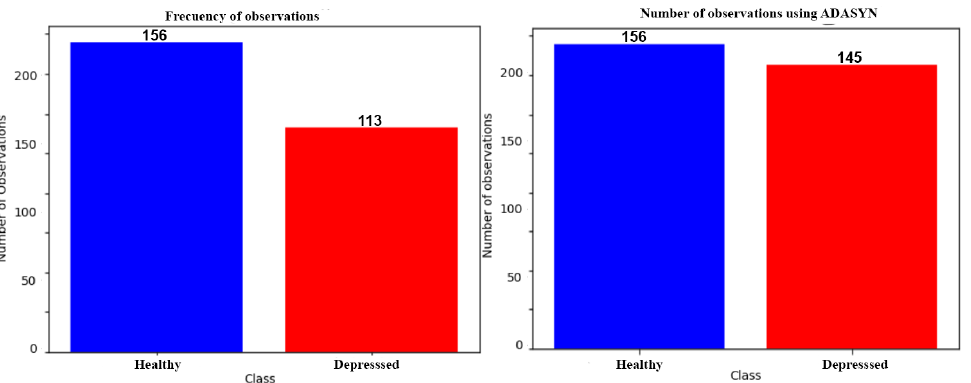
Figure 3. Graph of the number of observations. On the left side is the number of observations before class balancing and on the right side is the number of observations obtained using